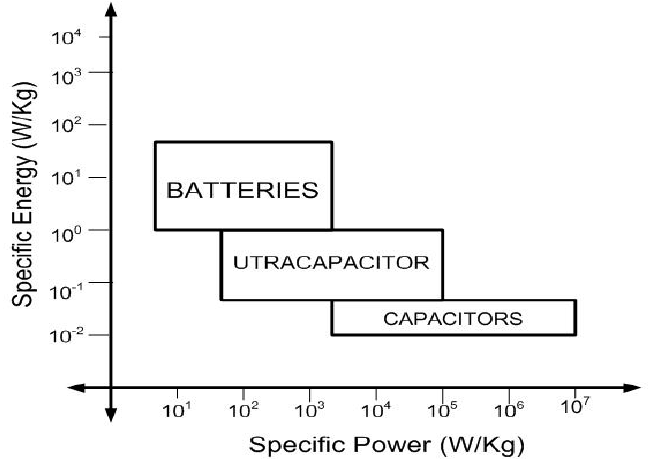
Figure 1. Ragone plot.